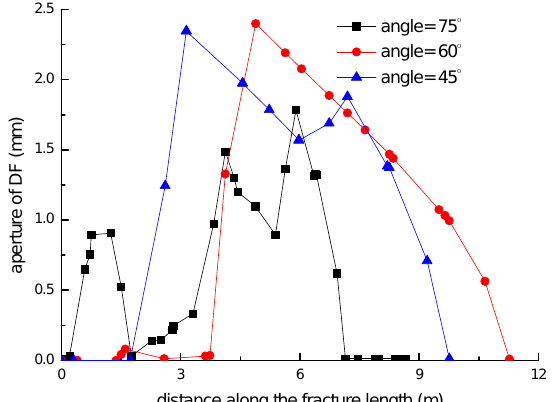
Figure 17. The fracture aperture curves of the DF along the fracture length direction at different levels of intersection angle between HF and NF. The distance in the x -axis is along the direction from the lower part to the upper part of the DF.